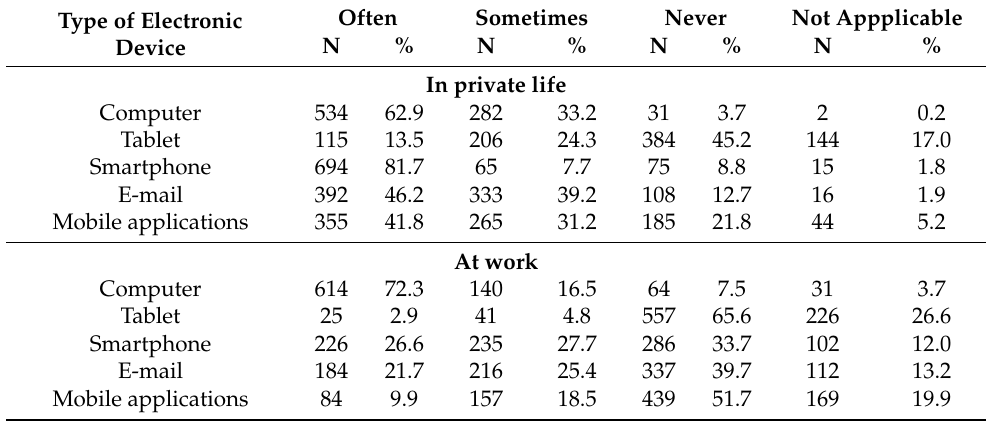
Table 2. The frequency of using electronic devices by nurses in private life and at work.